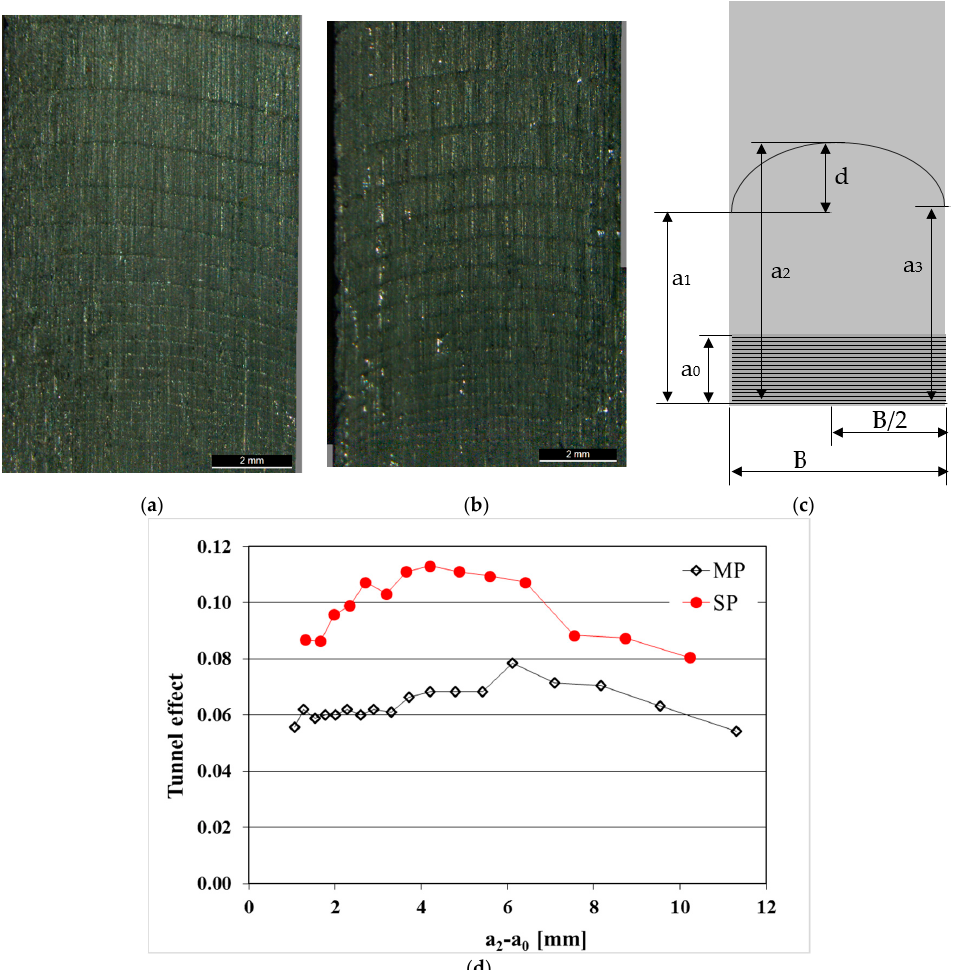
Figure 7 . Impression marks of the crack path and tunnel effect: ( a ) MP specimens; ( b ) SP specimens; ( c ) schematic indication for tunnel effect parameters; and ( d ) tunnel effect value distribution for MP and SP specimens. Appl. Sci. 2018 , 8 , x FOR PEER REVIEW